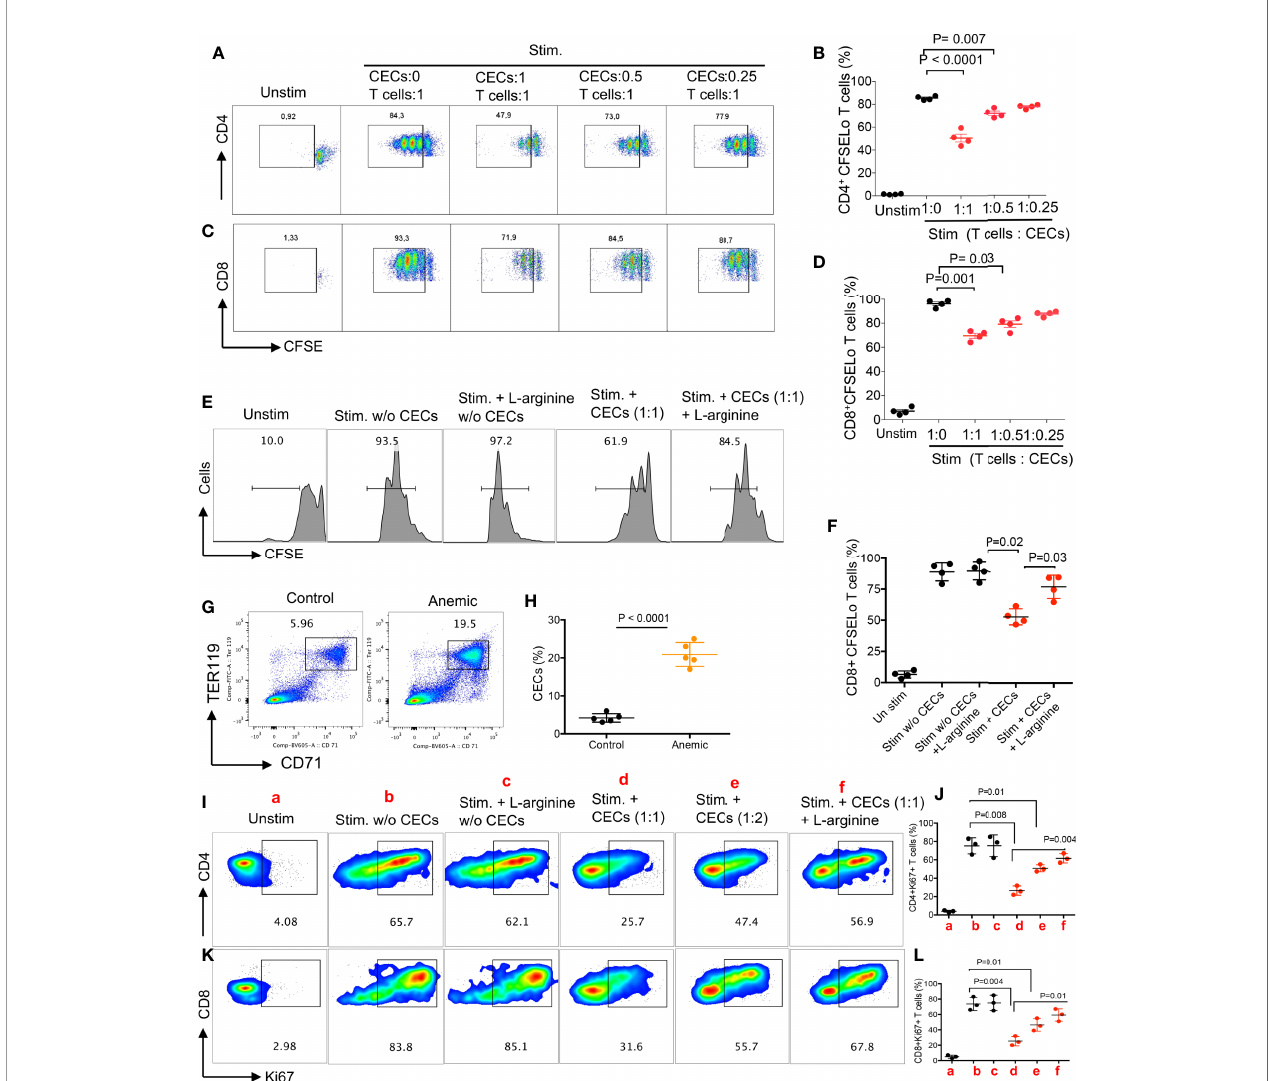
FIGURE 3 | CECs from female mice suppress T cell activation and proliferation. (A) Representative fl ow cytometry plots, and (B) cumulative data of CD4+ T cell proliferation as measured by CFSE dilution in the absence or presence of CECs at indicated ratios following stimulation with anti-CD3/CD28 for 3 days. (C) Representative fl ow cytometry plots, and (D) cumulative data of CD8+ T cell proliferation in the absence or presence of CECs at indicated ratios following stimulation with anti-CD3/CD28 for 3 days. (E) Representative fl ow cytometry plots, and (F) cumulative data of CD8+ T cell proliferation in the absence or presence of CECs at indicated ratios following stimulation with anti-CD3/CD28 for 3 days with or without (w/o) L-arginine supplementation (2 mM). (G) Representative fl ow cytometry plots, and (H) cumulative data of CECs in untreated (control) versus treated female mice with the anti-TER-119 antibody. (I) Representative fl ow cytometry plots, and (J) cumulative data for Ki67 expression in CD4+ T cells following stimulation for 24 h with anti-CD3/CD28, in the absence or presence of CECs (different indicated ratios) and with or without (w/o) supplementation with L-arginine (2 mM). (K) Representative fl ow cytometry plots, and (L) cumulative data for Ki67 expression in CD8+ T cells following stimulation for 24 h with anti-CD3/CD28, in the absence or presence of CECs (different indicated ratios) and with or without (w/o) supplementation with L-arginine (2 mM). Each point represents data from an individual mouse, representative of at least three independent experiments. Bar, mean ± standard